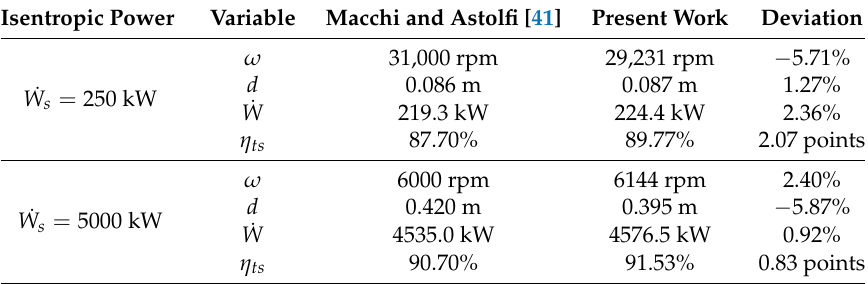
Table 4. Output of the optimization methodology for two reference optimization problems. Isentropic